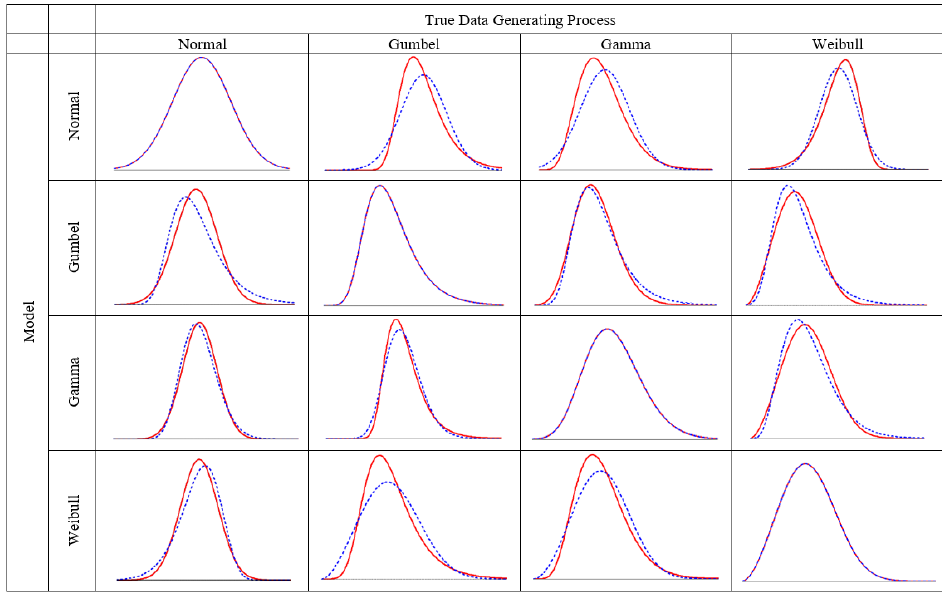
Table 1. Probability density functions of the true data generating process (solid curve) and the estimated model (dashed curve) evaluated at X=0 for the Monte Carlo